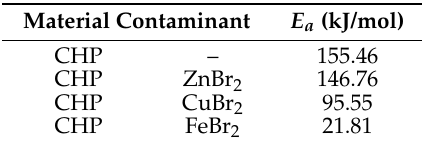
Table 4. Apparent activation energy of CHP decomposition after mixing CHP with ZnBr 2 , CuBr 2 , or FeBr 2 individually; the apparent activation energy was obtained using the Arrhenius equation.